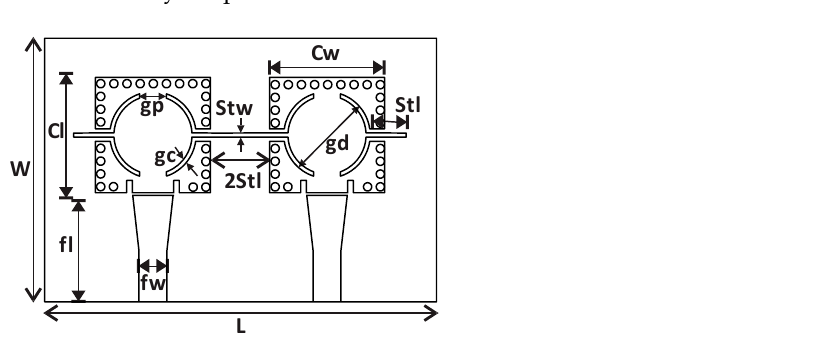
Figure 1. SIW filter with loosely coupled feed lines; dimensions are (in mm): L = 47, W = 32, Cl = Cw = 14, fl = 12.75, fw = 3.63, gp = 3.6, gc = 0.5, stw = 0.5, stl = 4.4, gd = 10.5.